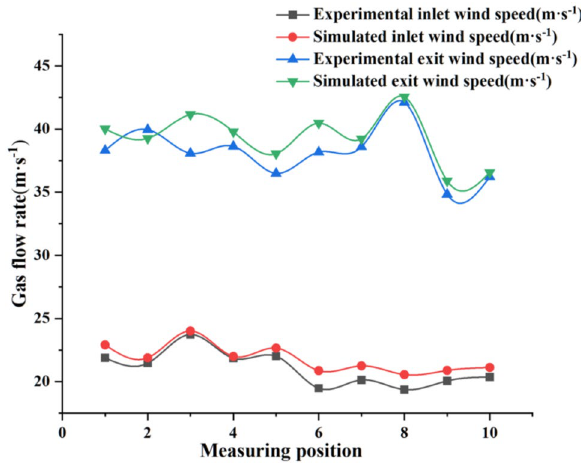
Figure 9. Comparison of gas phase test and simulation results.